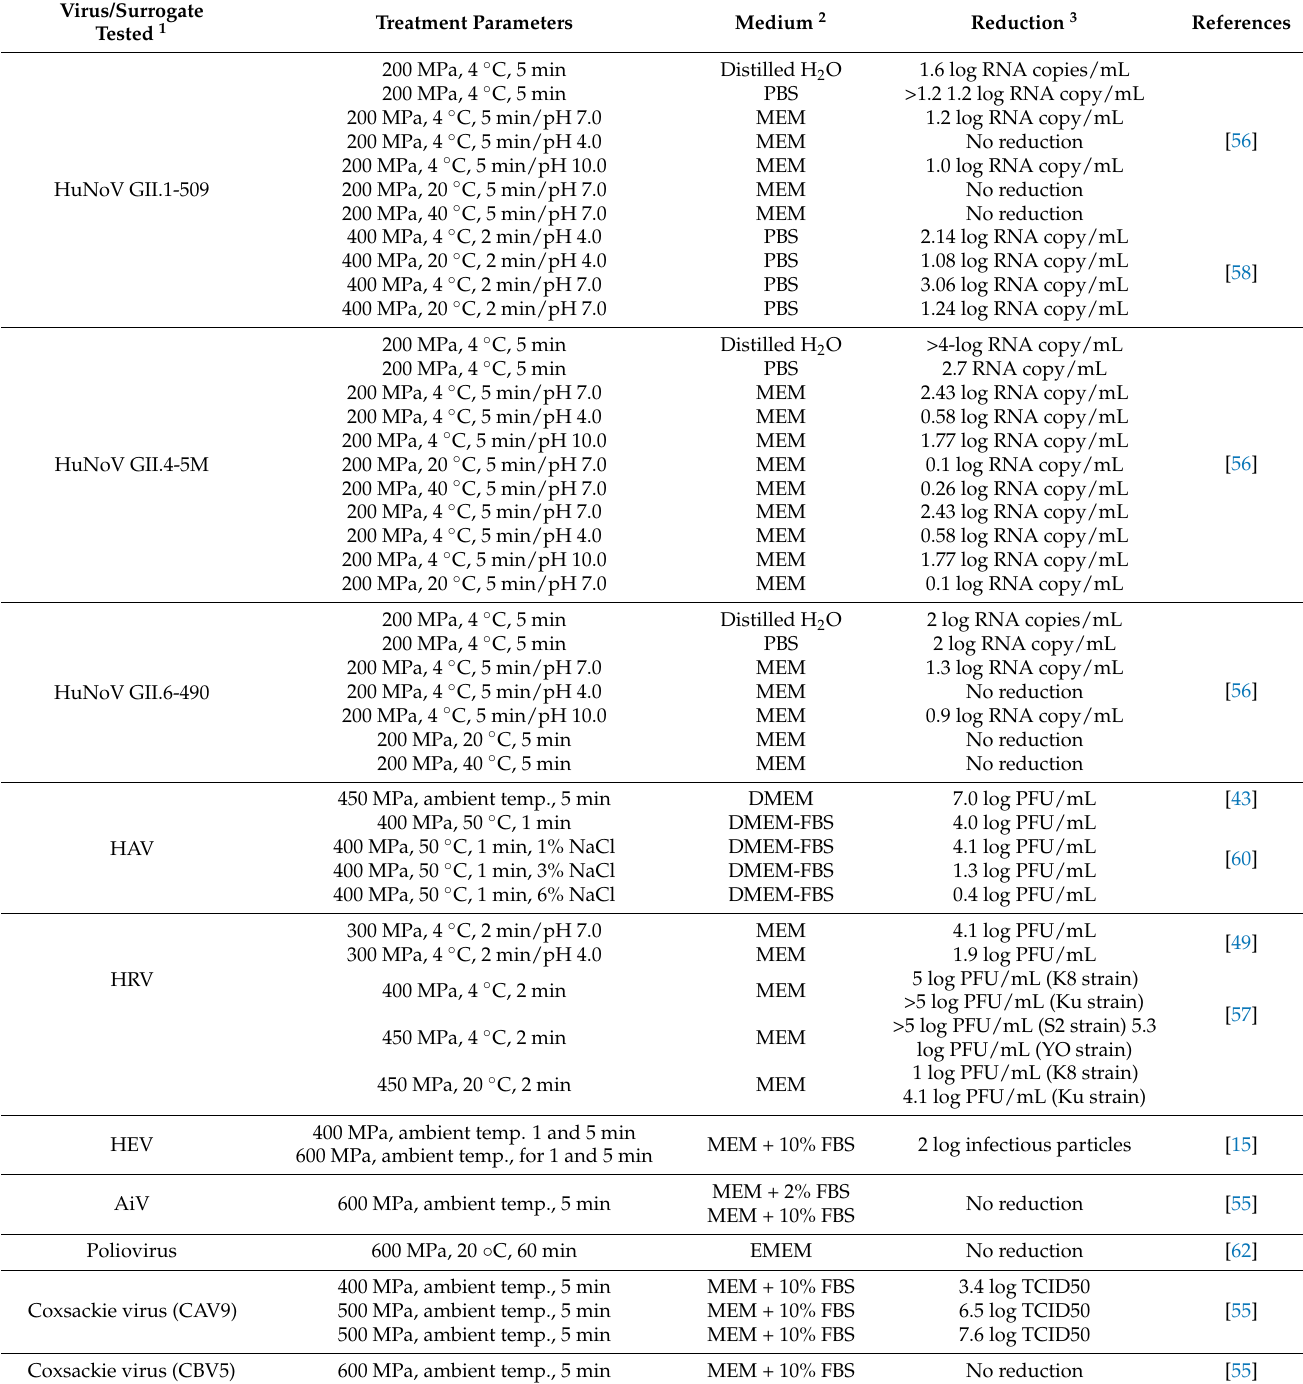
Table 2. Inactivation of foodborne viruses/surrogates during HPP treatments in laboratory media. Virus/Surrogate Tested